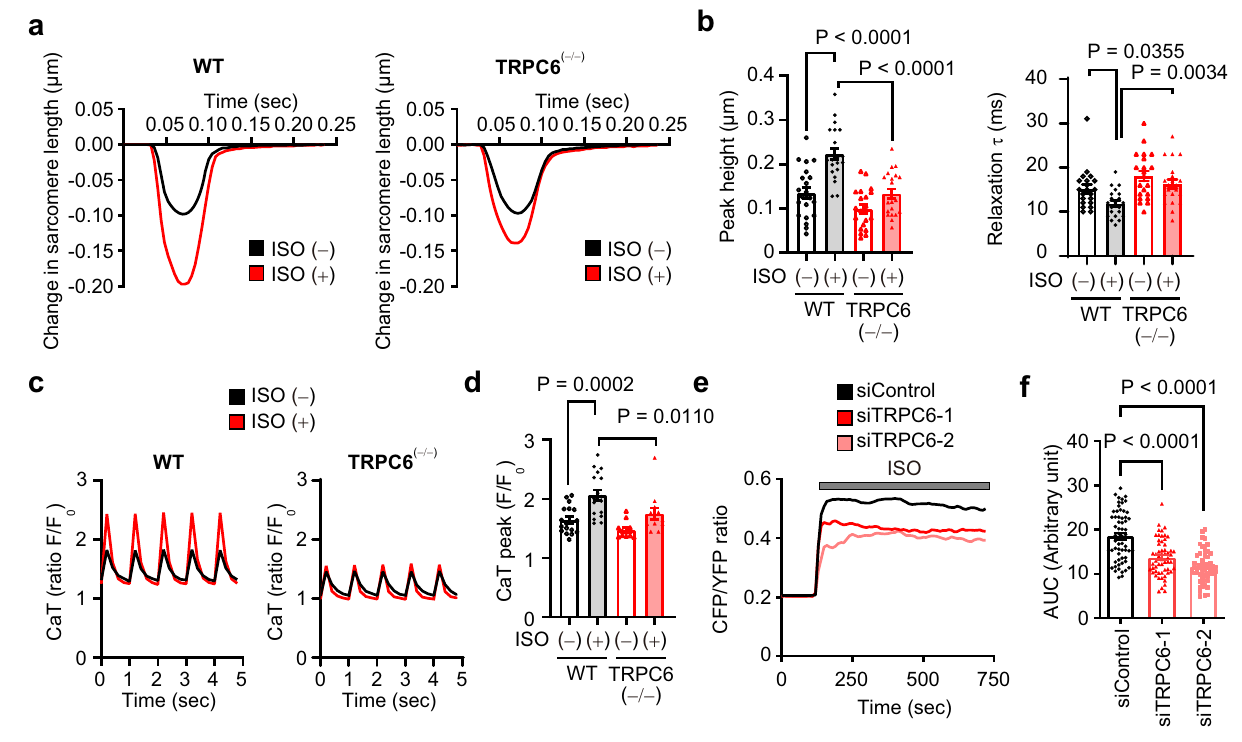
Fig. 3 | TRPC6 deletion reduces β AR-stimulated contraction in adult mouse cardiomyocytes. a , b Representative traces of sarcomere length changes ( a ) and summarized results of peak heights and relaxation time τ ( b ) induced by ISO sti- mulation (10nM). Isolated mouse (129/Sv) cardiomyocytes were excited by fi eld stimulationat4Hz.WT, n =21cells;TRPC6 ( − / − ) , n =21cells.Representativetracesof calciumtransients(CaT)( c )andsummarizedresultsofpeakamplitudesofCaT( d ). Fluo4-loaded cardiomyocytes were stimulated with ISO (10nM) under fi eld sti- mulation of 10 msec, 50V at 1Hz. WT, n =17 cells; TRPC6 ( − / − ) , n =12 cells. e, f